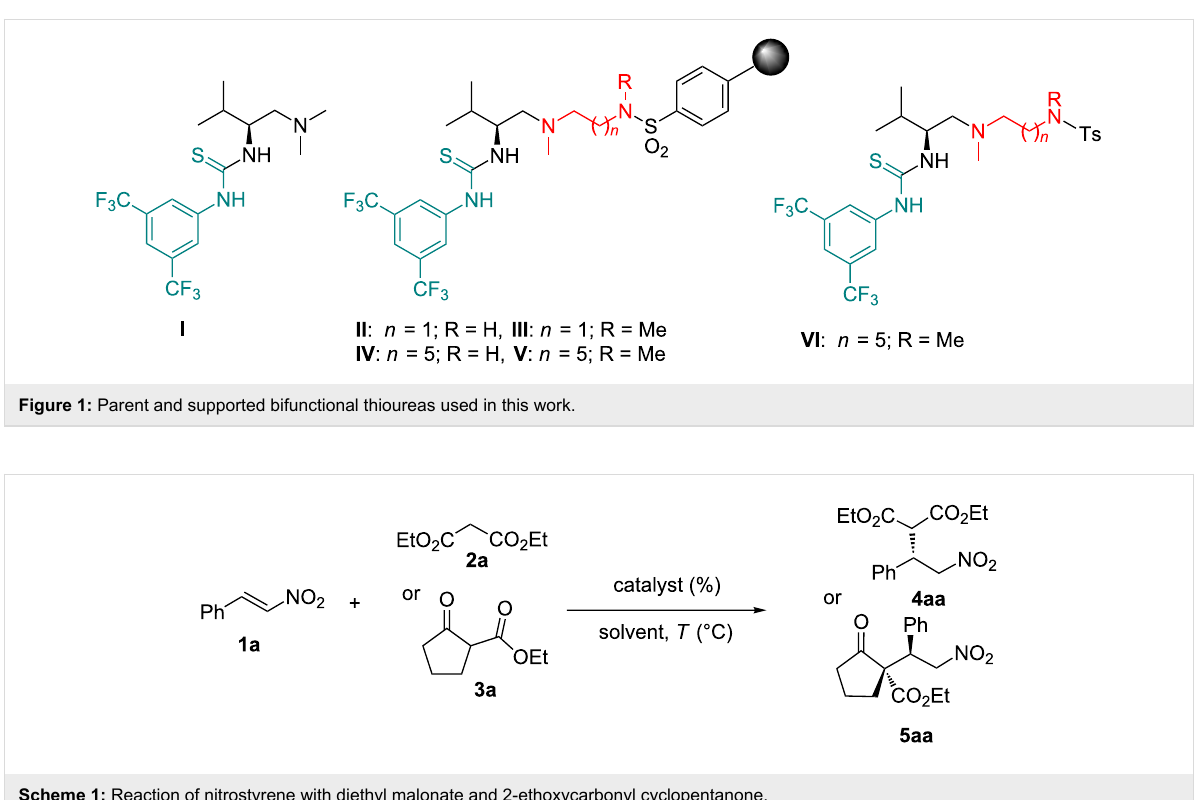
Scheme 1: Reaction of nitrostyrene with diethyl malonate and 2-ethoxycarbonyl